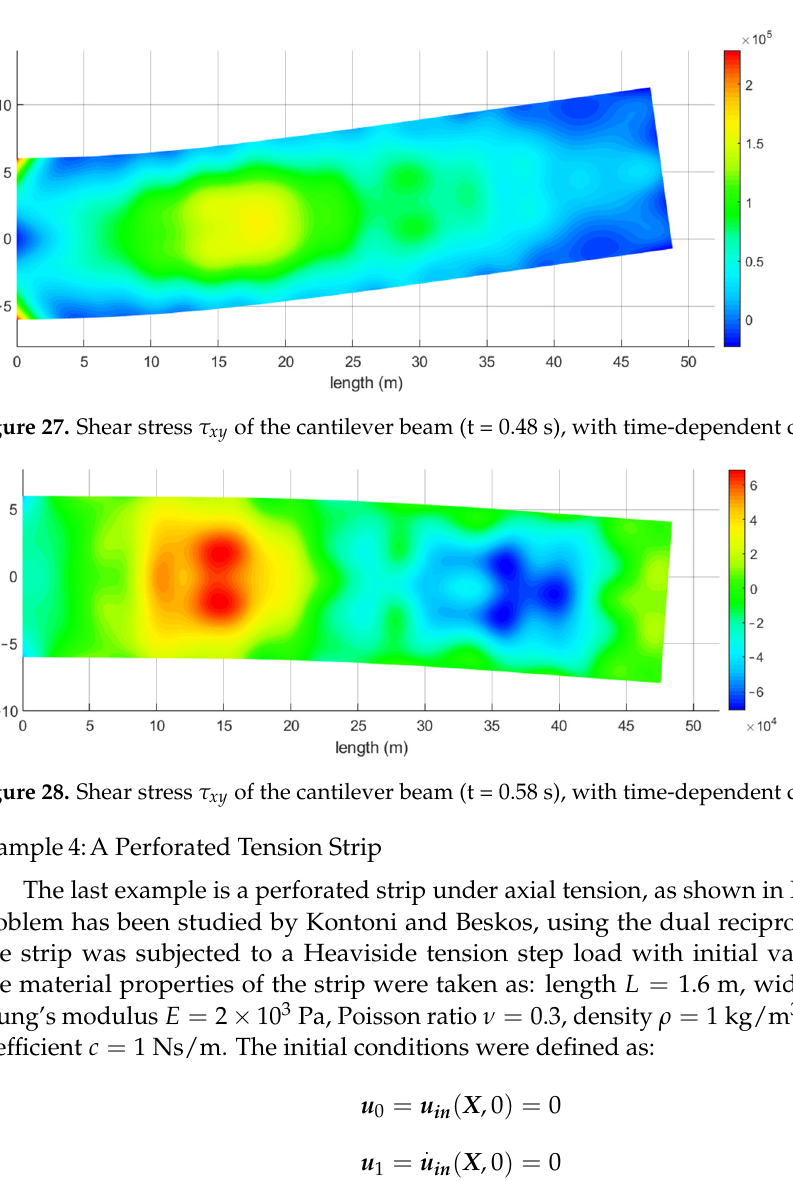
Figure 26. Shear stress 𝜏 (cid:3051)(cid:3052) of the cantilever beam (t = 0.4 s), with time-dependent damping.